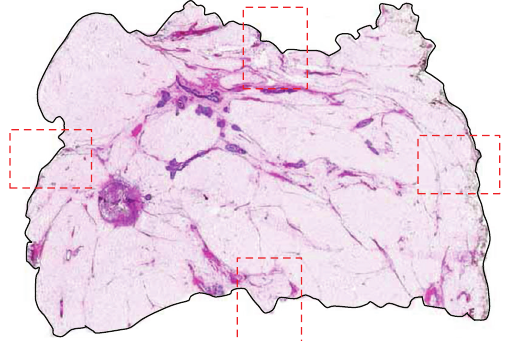
Figure 4: Large-format histologic section of a lumpectomy speci- men. The circumferential large-format surgical margin is outlined with solid black line. Conventional margin evaluation would consist of four axis margin sections in one plane represented here by broken red rectangles (H&E).